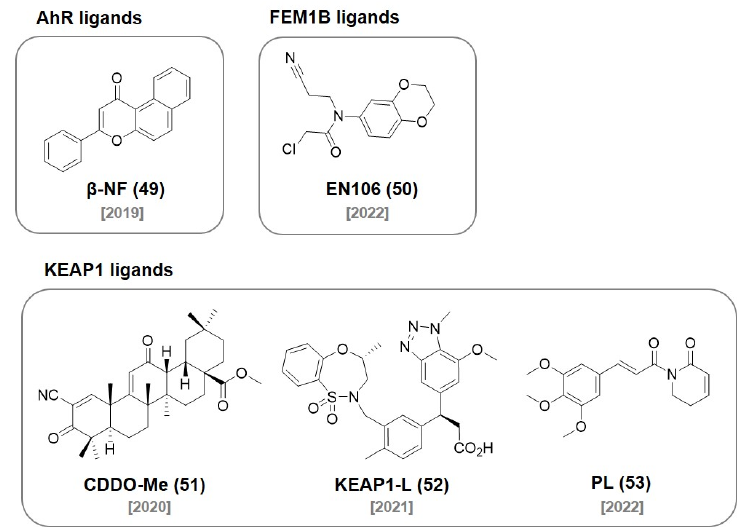
Figure 16. Recently developed AhR , FEM1B , and KEAP1 ligands.